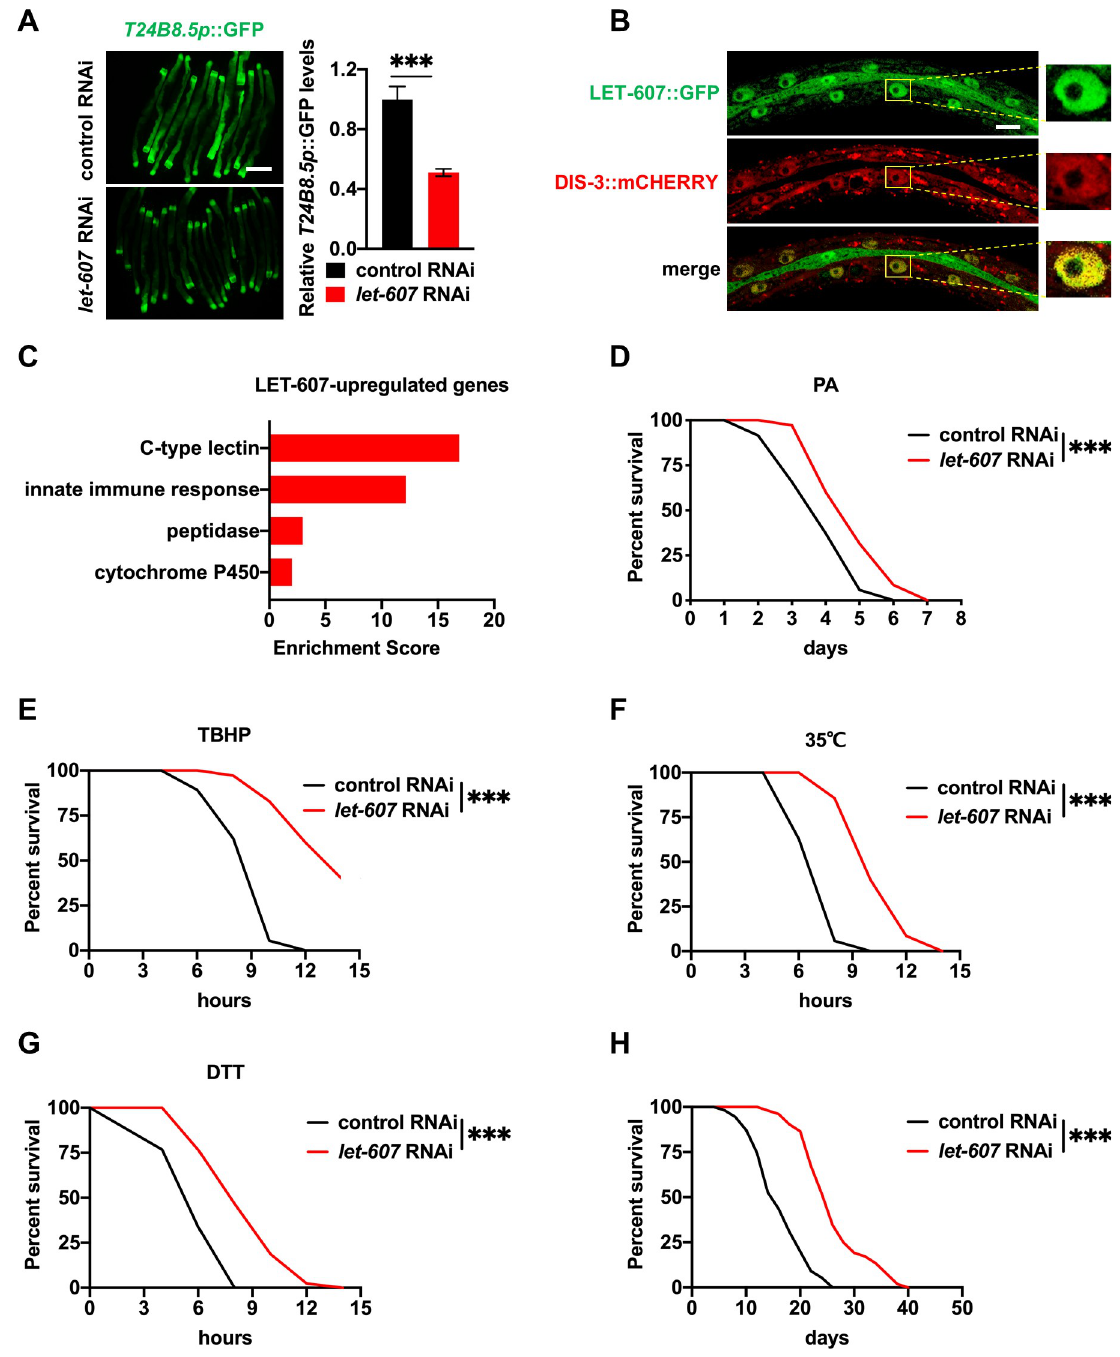
Fig 1. LET-607 regulates stress responses. (A) Effects of let-607 RNAi on T24B8 . 5p ::GFP expression at 25˚C. Left panel, representative images. Right panel: quantification data. Scale bar = 100 μ m. (B) Nuclear expression of LET-607::GFP. LET-607::GFP overlap with DIS-3:: mCHERRY in the nucleoplasm. Scale bar = 10 μ m. (C) Functional classification analysis of genes upregulated by LET-607. (D-G) Effects of let-607 RNAi on pathogen resistance (D), TBHP resistance (E), 35˚C heat stress resistance (F) and DTT resistance (G). (H) Effects of let-607 RNAi on C . elegans lifespan. Data were presented as mean ± SEM. ��� p < 0.001 versus empty vector controls.